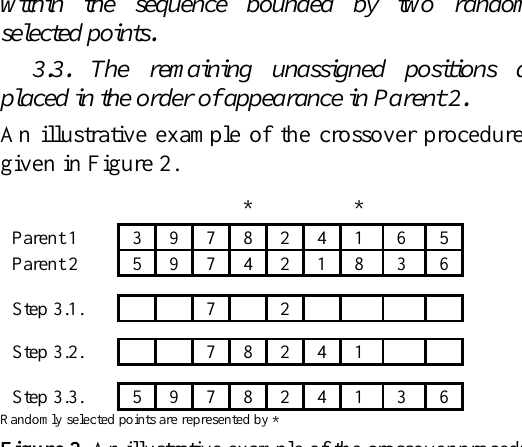
Figure 2. An illustrative example of the crossover procedure